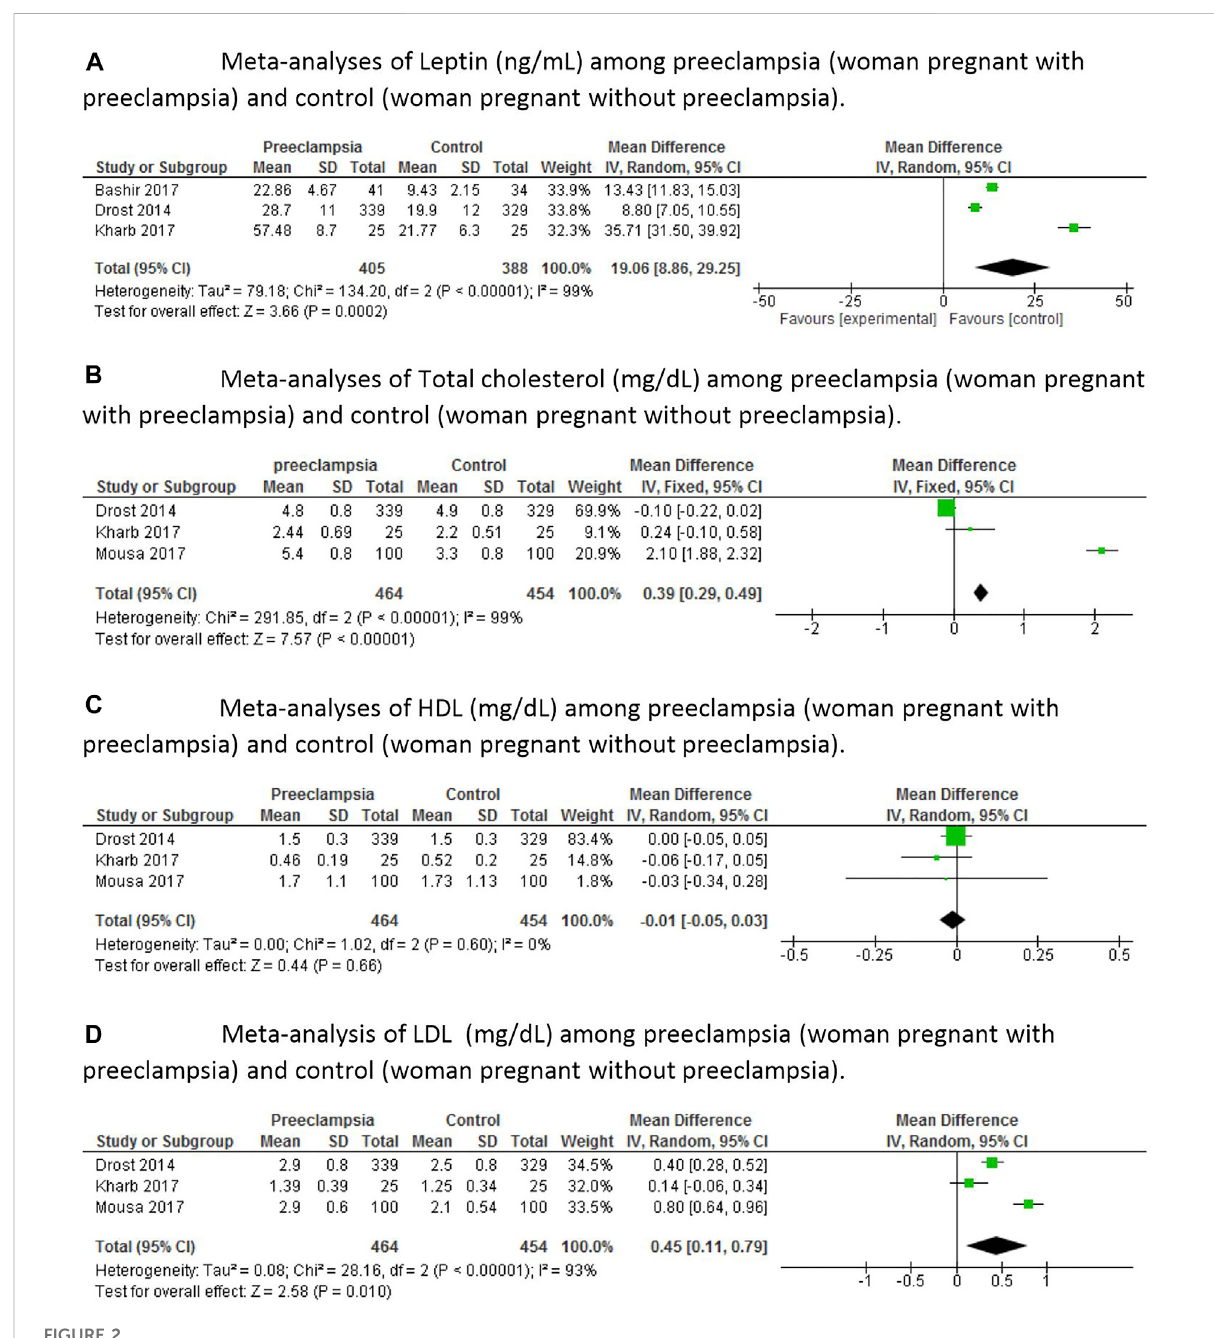
FIGURE 2 Meta-analyses of in fl ammatory markers among pregnant women with preeclampsia and control pregnant women (control), that is, without preeclampsia. (A) — Meta-analyses of Leptin (ng/ml) among preeclampsia (woman pregnant with preeclampsia) and control (woman pregnant without preeclampsia). (B) — Meta-analyses of Total cholesterol (mg/dl) among preeclampsia (woman pregnant with preeclampsia) and control (woman pregnant without preeclampsia). (C) — Meta-analyses of HDL (mg/dl) among preeclampsia (woman pregnant with preeclampsia) and control (woman pregnant without preeclampsia). (D) — Meta-analysis of LDL (mg/dl) among preeclampsia (woman pregnant with preeclampsia) and control (woman pregnant without